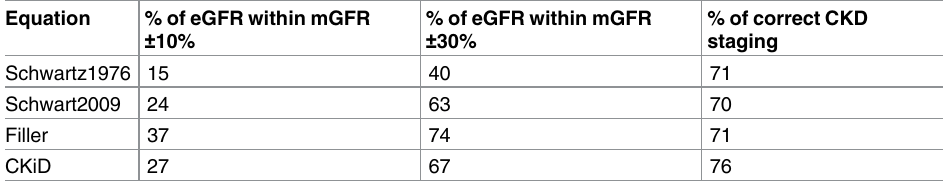
Table 4. Accuracy of GFR estimation by different equations.